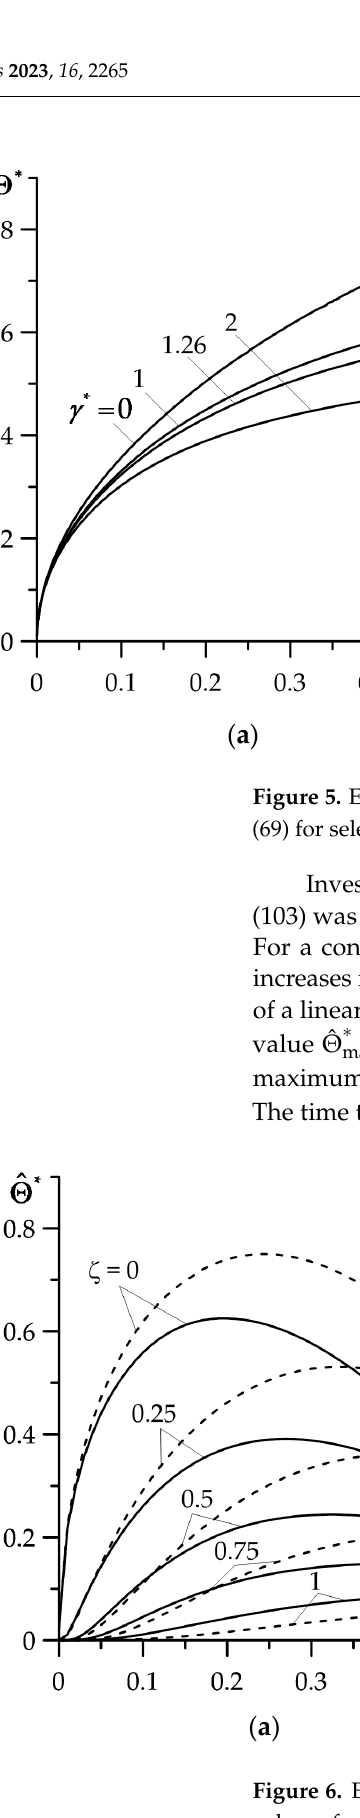
ττ = (Figure 6b). Both at a constant and at the time-dependent intensity of the heat max s flux, consideration of the FGC gradient causes a drop in the temperature value in relation to the temperature of the coating made of a homogeneous material. In the substrate, the situation is opposite—at fixed value of ζ , the temperature is lower in case of a homo- geneous coating material. Regardless of the coating material (FGM or homogeneous), the substrate temperature is an order lower than in the coating. Spatial-temporal distributions of temperature are presented in Figure 7, for constant and time-dependent heat flux intensities. Visible differences between the shape of the corresponding isotherms occur only in the more heated element of the system—the coating that absorbs the main part of the thermal load. In the case of a constant intensity of the heat flux, the isotherms with a fixed temperature level go deeper inside the FGC during the whole heating process. On the other hand, during heating by a heat flux with linearly decreasing intensity over time, the isotherms in the coating reach the maximum distance from the heated surface before the end of the process.